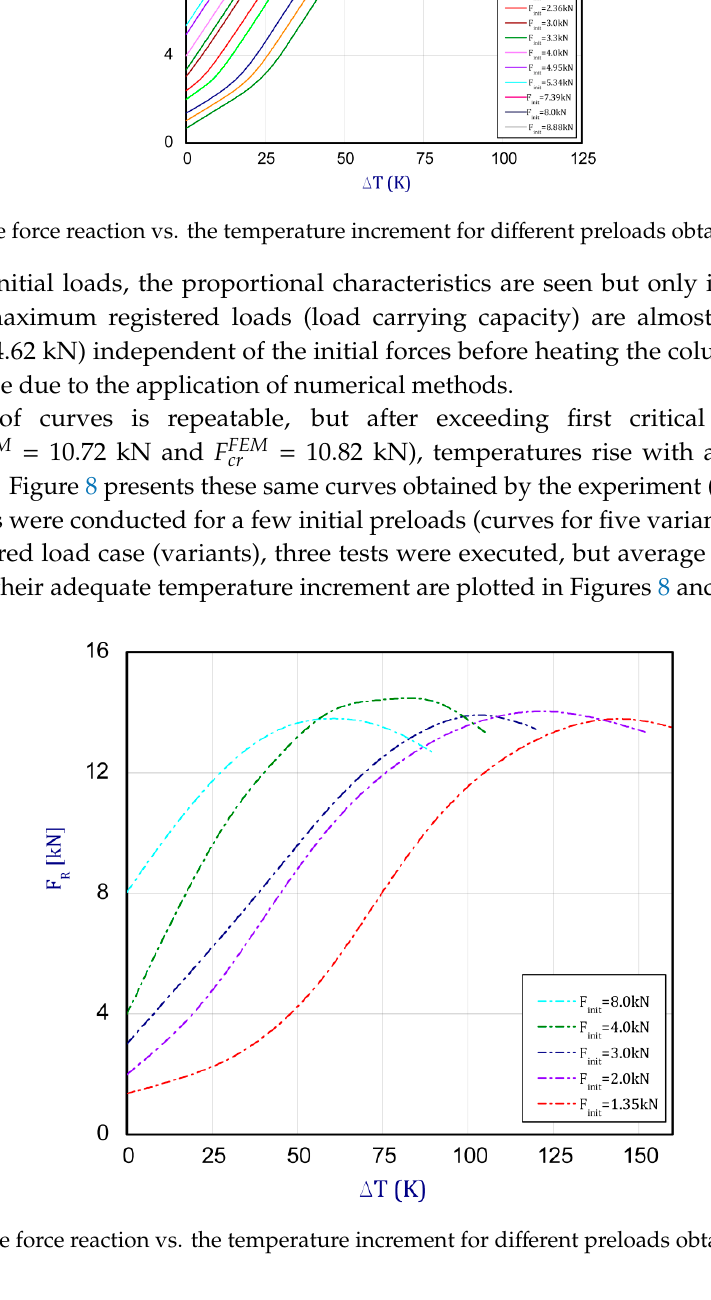
Figure 9. Comparison of obtained curved by FEM and EXP. In the case of the experiment, the curves have similar trends as in FEM, but the received maximum loads and the maximum temperature increment differ slightly from each other. These characteristic values are shown in Table 4. To highlight differences, some curves obtained experimentally and numerically are compared and plotted in Figure 9. Taking into consideration the maximum reaction forces obtained numerically and experimentally, the discrepancy amounted to a few percent (for F int = 1.35 kN–5.2%, for F int = 2.0 kN–3.5%, for F int = 3.0 kN–3.7%, F int = 4.0 kN–0.1%, and for F int = 8.0 kN–4.53%). To better visualize the behavior of the columns in the thermal environment, the deformation maps of the specimens based on DICAS and FEM are shown in Table 5. Many points of the measurements gave quite a good correlation (for example, cases: F int = 2 kN– point 3, F int = 3 kN–point 3, and F int = 4 kN–point 3).